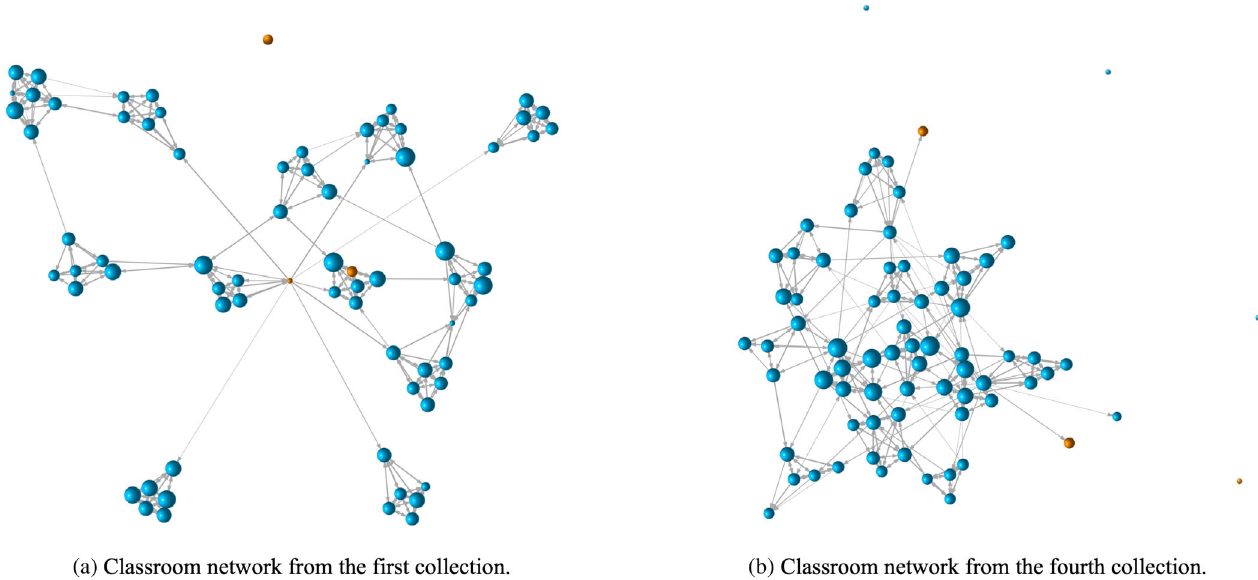
FIG. 4. Network visualization for two different collection times. At the first collection, ties largely represent seating arrangement; at the fourth collection, the structure of ties is demonstrably more complex. This structural difference is indicative of the network ’ s development over time. The three orange nodes indicate students who did not complete the class. It is interesting to observe how they over time moved from fairly central position in the network (a) to being either at a peripheral position or completely disconnected by week 11. The size of nodes represents closeness at the fourth collection.